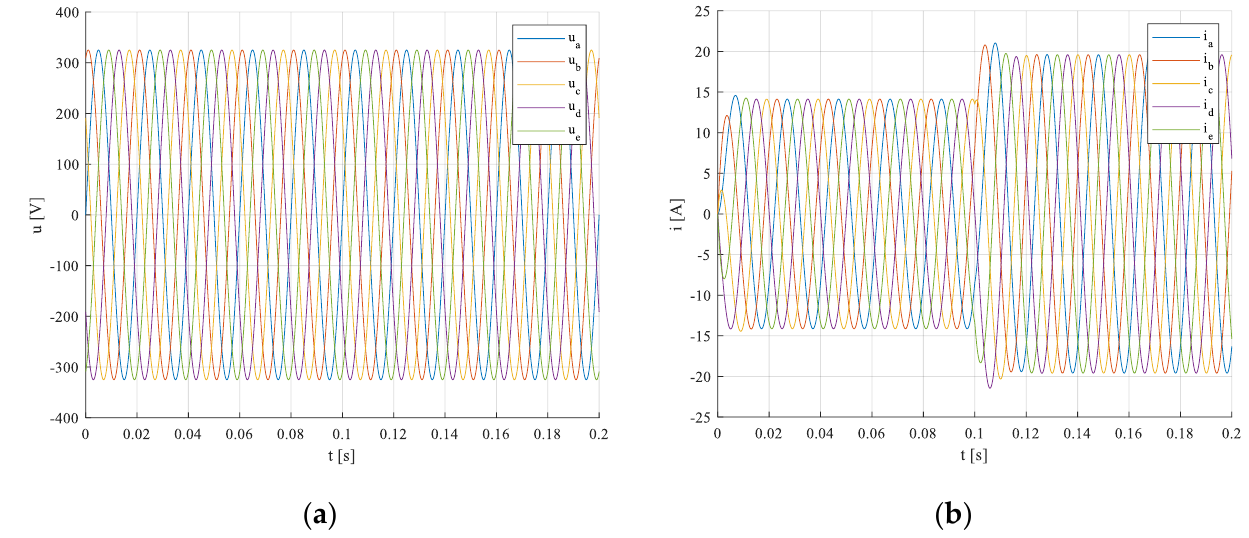
Figure 9. Phase voltages ( a ) and currents ( b ) in 𝑎, 𝑏, 𝑐, 𝑑, 𝑒 — coordinates. Apparent, active, blind, and distortion powers during transient states are shown, due to comparison to 5- and 2-phase systems, in Figure 11a–d.